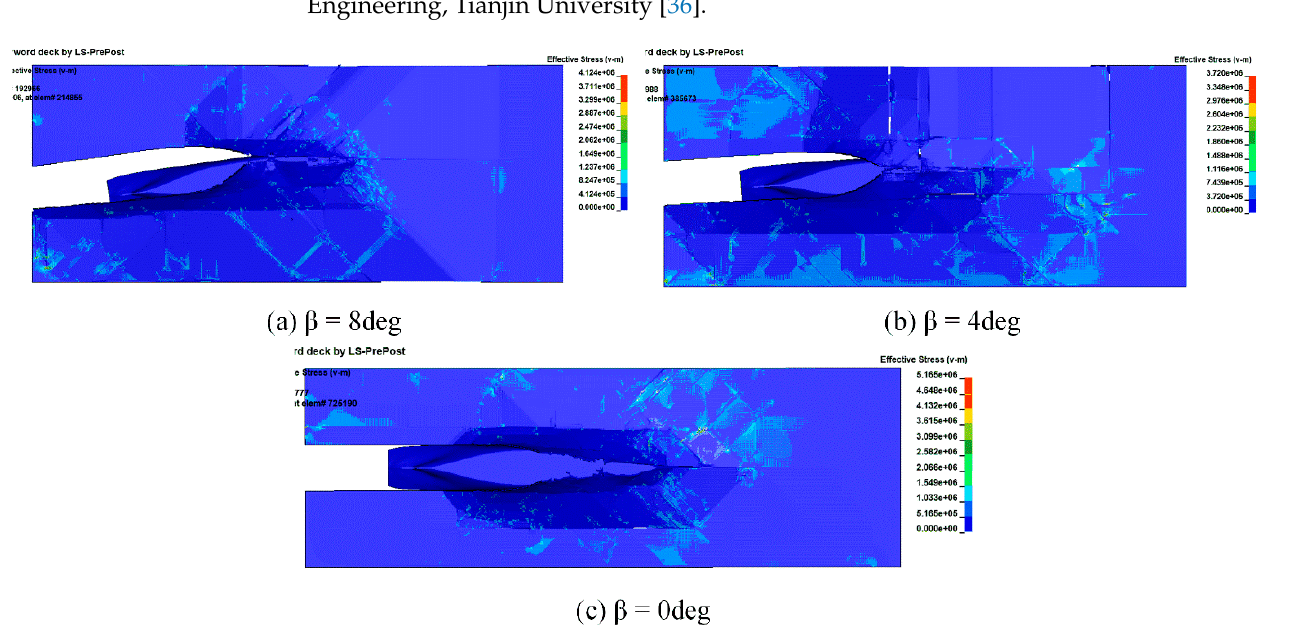
Figure 15. Box plot of F tra under different drift angles.